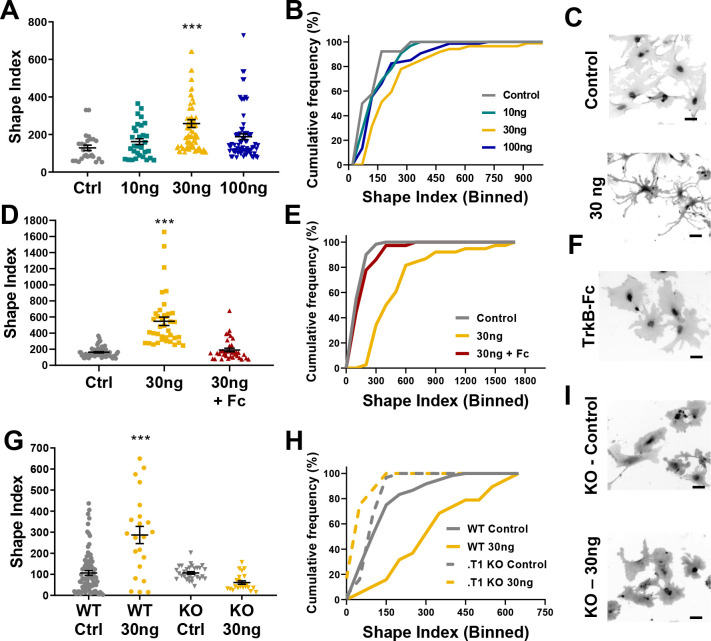
Astrocyte morphological complexity is sensitive to BDNF/TrkB.T1 signaling.(A) SI analysis and (B) cumulative frequencies following exposure to varying concentrations of BDNF for 24 hr. (C) Representative images of control and 30ng-treated astrocytes. (D, E) Complexity analysis of astrocyte morphology following scavenge of BDNF with TrkB-Fc, (F) representative image of TrkB-Fc scavenged astrocytes. (G–I) Morphological complexity analysis of cultured astrocytes lacking the TrkB.T1 receptor in the presence of BDNF. Data represented as mean + /- SEM, n = 3–6 cultures, with two wells collected per culture. Each symbol represents an individual cell. Scale bars indicate 20 microns. *p<0.05, **p<0.01, ***p<0.0001. Each data point represents an individual cell.